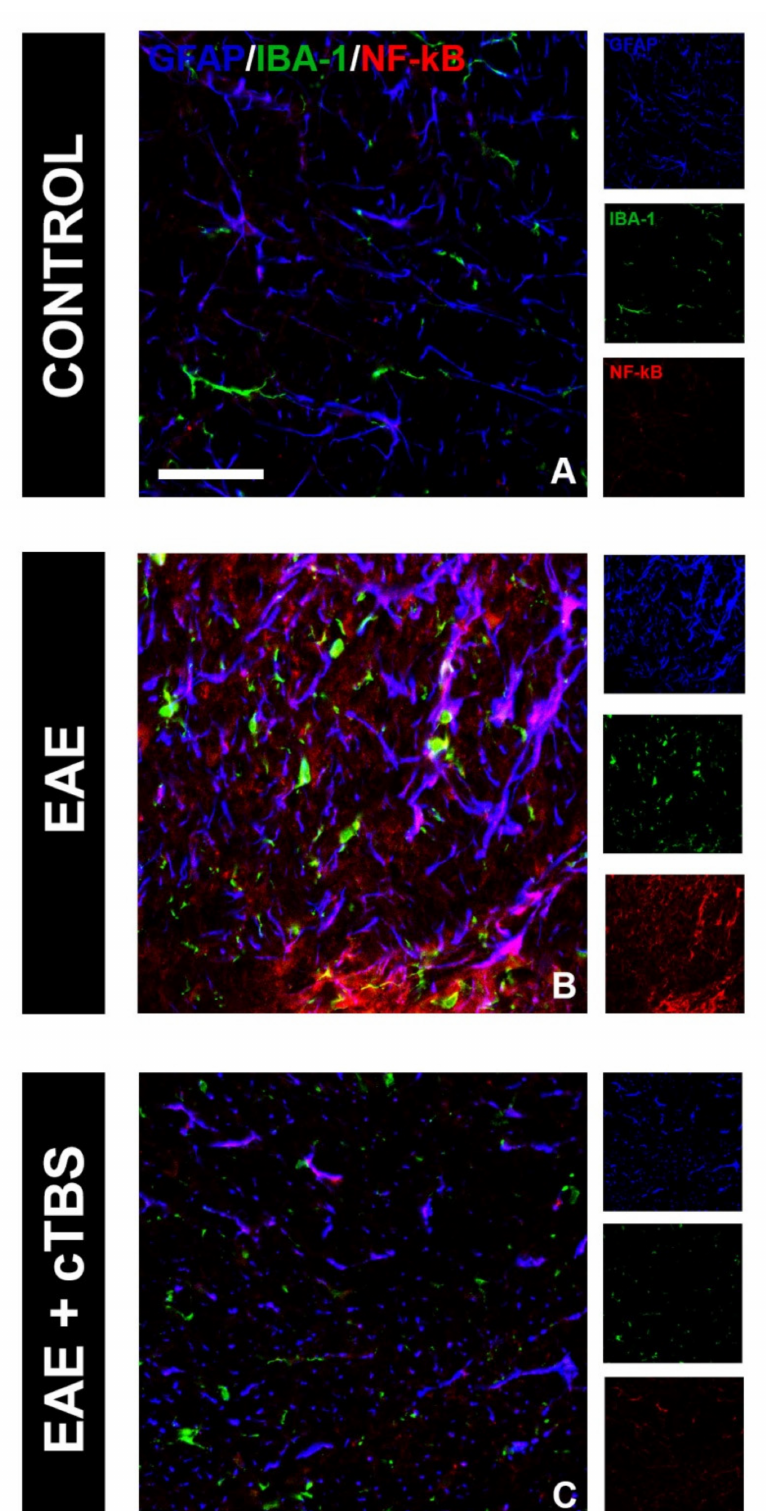
Figure 4. Effects of CTBS treatment on NF- κ B expression in EAE rats. Triple immunofluorescence labeling directed to astrocyte marker GFAP (blue), microglial marker IBA-1 (green), and NF- κ B (red). Faint colocalization of NF- κ B- ir and GFAP was observed in control sections ( A ). In EAE sections, a marked increase in NF- κ B- ir was observed predominantly colocalizing with GFAP + cells ( B ). CTBS treatment decreased immunostaining of NF- κ B, and only scattered NF- κ B + /GFAP + cells were observed ( C ). Scale bar corresponds to 50 µ